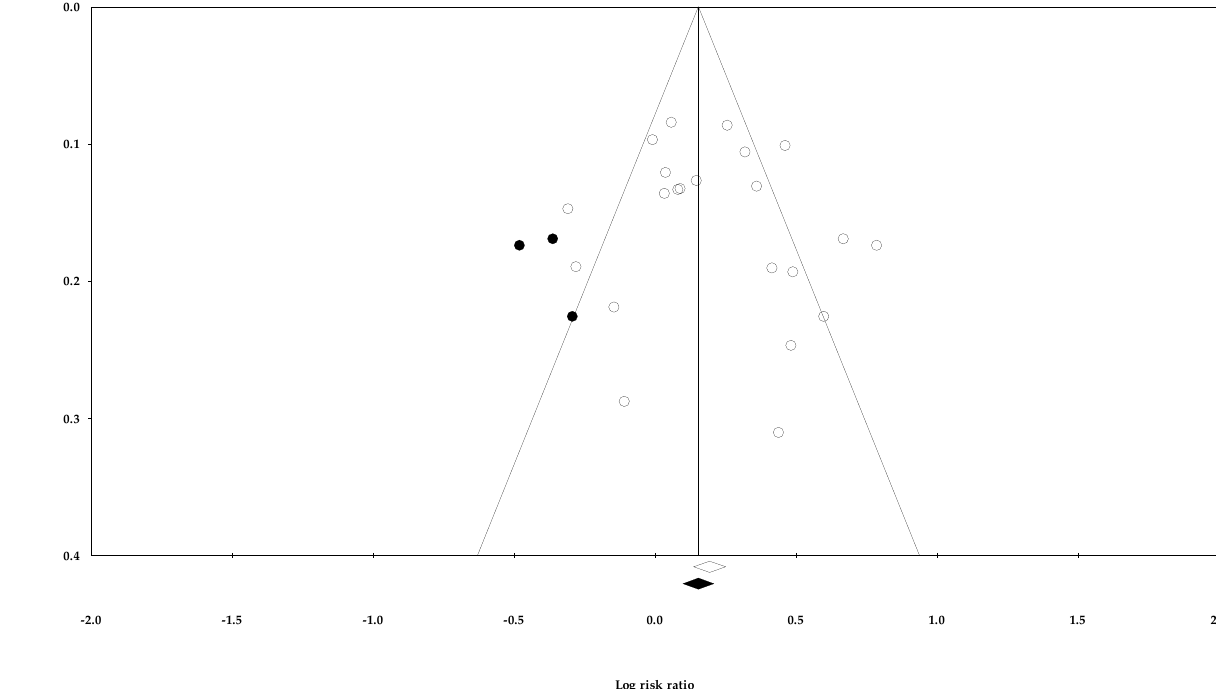
Figure 4. A funnel plot of relative risk for the target blood pressure rate. Note: summary effect size ( ◇ ), imputed study ( ● ), summary effect size of imputed studies ( ◆ ), individual study ( ○ ).